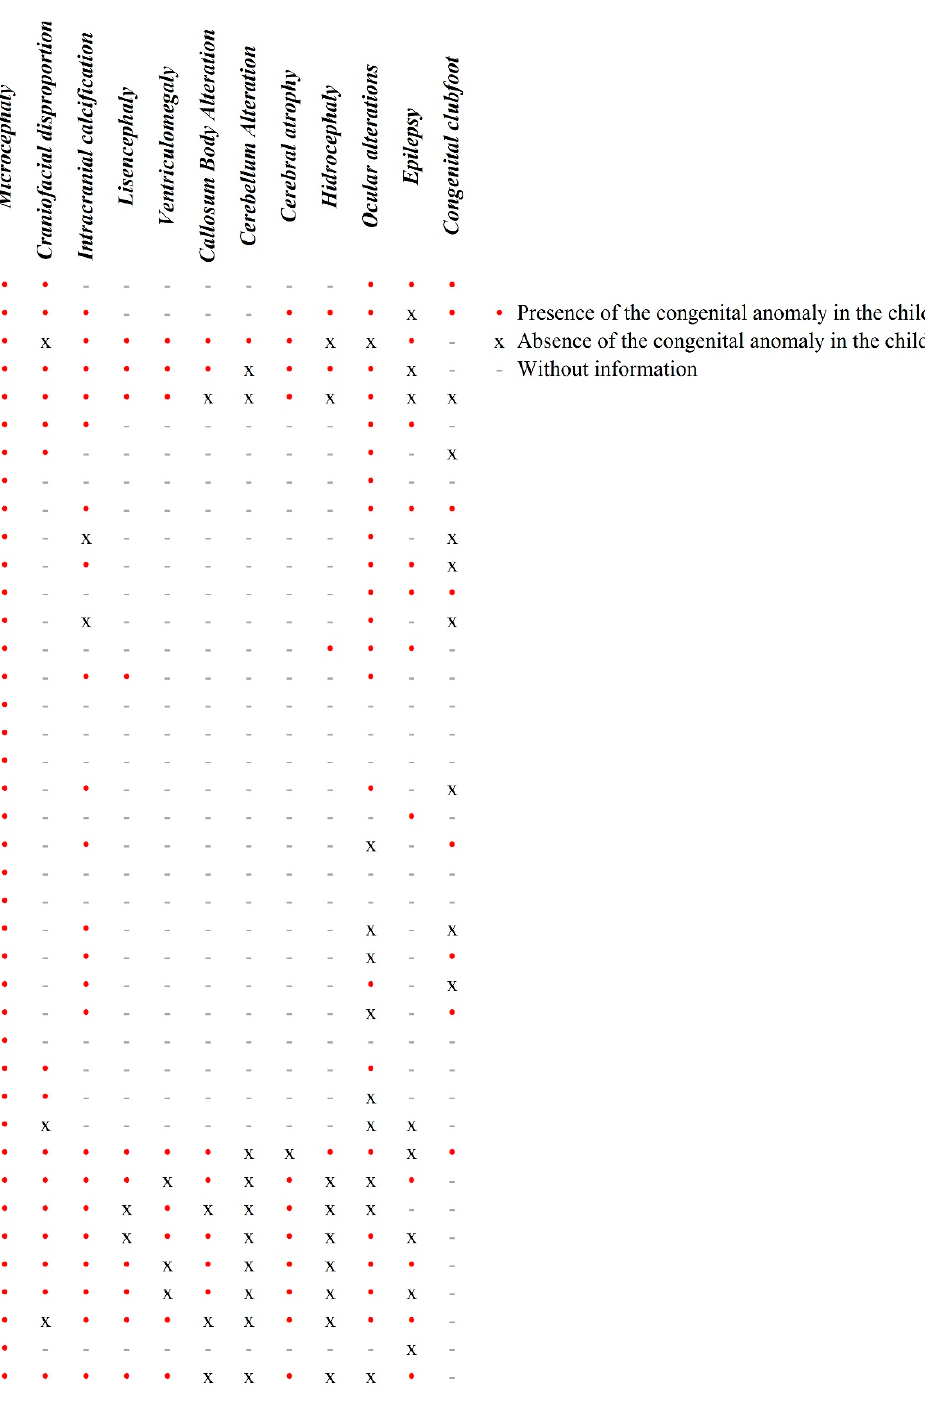
Figure 1. Descriptive analysis of the clinical findings of each individual of the case group. The allelic and genotypic frequencies of polymorphisms in the VEGFA, PTGS2, NOS3, TNF, and NOS2 genes in both groups are presented in Table 2. The genotypic frequencies of the rs1799983 ( NOS3 ), rs1799724 ( TNF ), rs2779249, and rs2297518 ( NOS2 ) in the control group were not consistent with the Hardy–Weinberg equilibrium as well as the genotypic frequencies of the rs2297518 ( NOS2 ) in the case